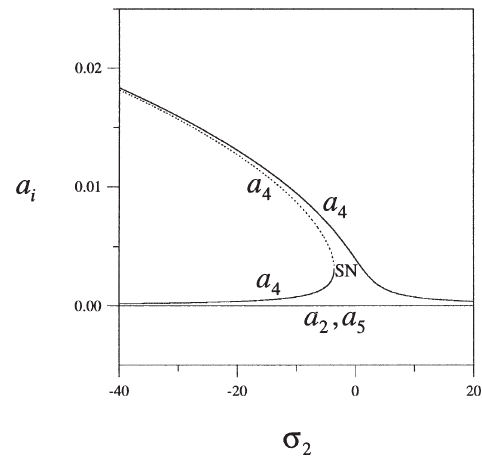
Fig. 1. Frequency-response curves for the case (cid:10) (cid:25) ! 4 (cid:25) 1 ( ! 2 + ! 5 ) when F = 10, (cid:27) 1 = (cid:0) 5, (cid:22) 2 = 0 : 0635, (cid:22) 4 = 0 : 0573, 2 and (cid:22) 5 = 0 : 0400. Solid lines (—) denote stable fixed points and dotted lines ( (cid:1)(cid:1)(cid:1) ) denote unstable fixed points. SN denotes a sad- dle-node bifurcation.